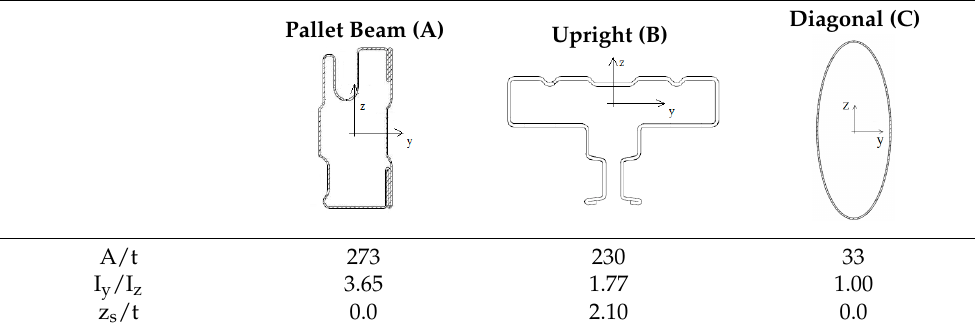
Table 1. Main properties of the considered sections.